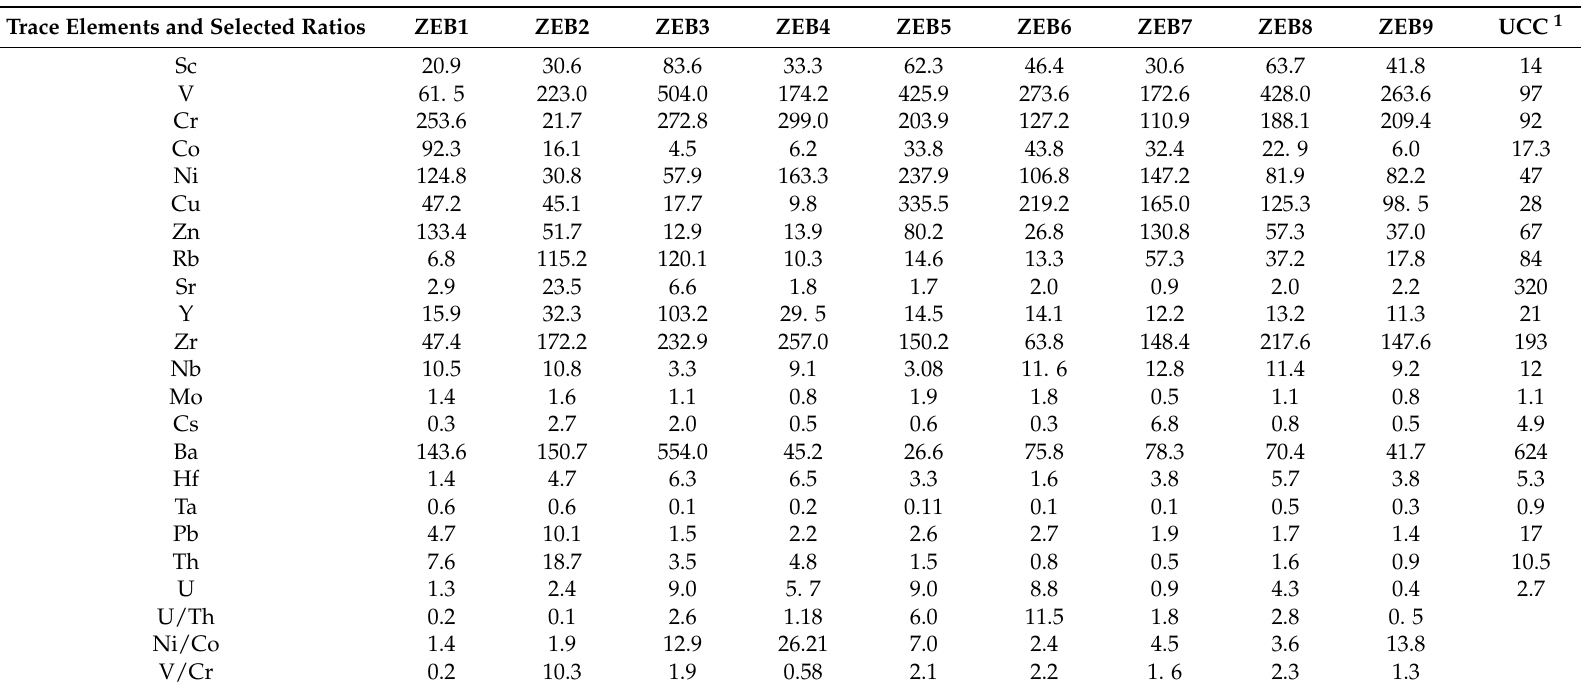
Table 4. Trace element composition in ppm of the clay size fraction of the Zebediela kaolin (arranged in increasing atomic number from Sc to U). Trace Elements and Selected